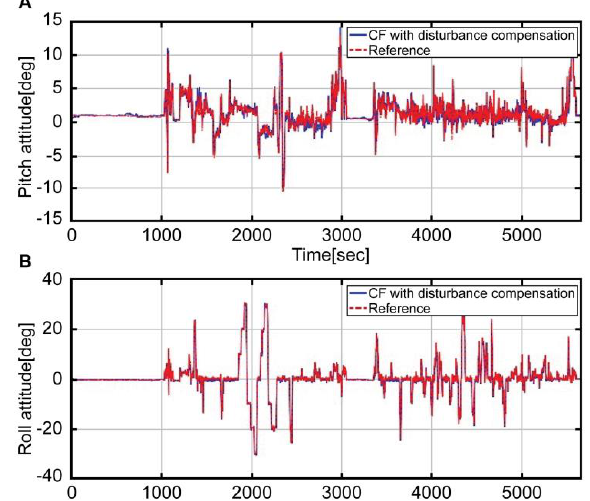
Figure 10. Attitude result with compensation by the complementary filter (blue solid line) and Reference attitude (red dotted line); A: Pitch attitude, B: Roll attitude.